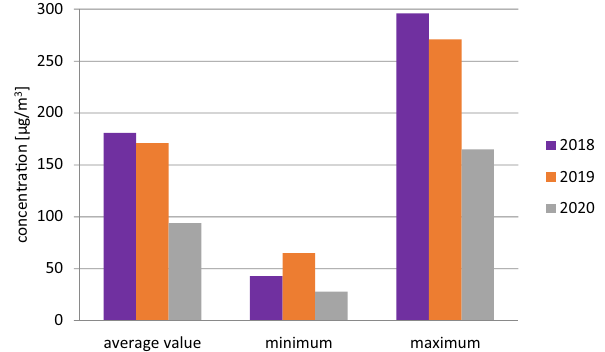
Figure 4: Comparison of average values, minimum and maximum of average - daily concentration of NO x in the air in Krakow at on data from ref. [ 25 ]